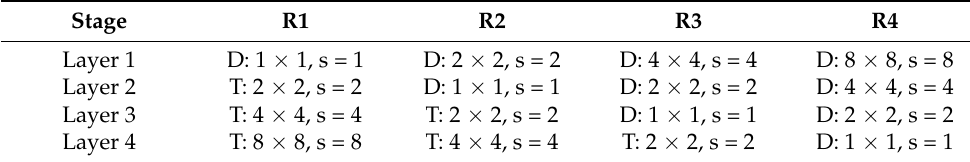
Table 2. Details of the pyramid cross-fusion